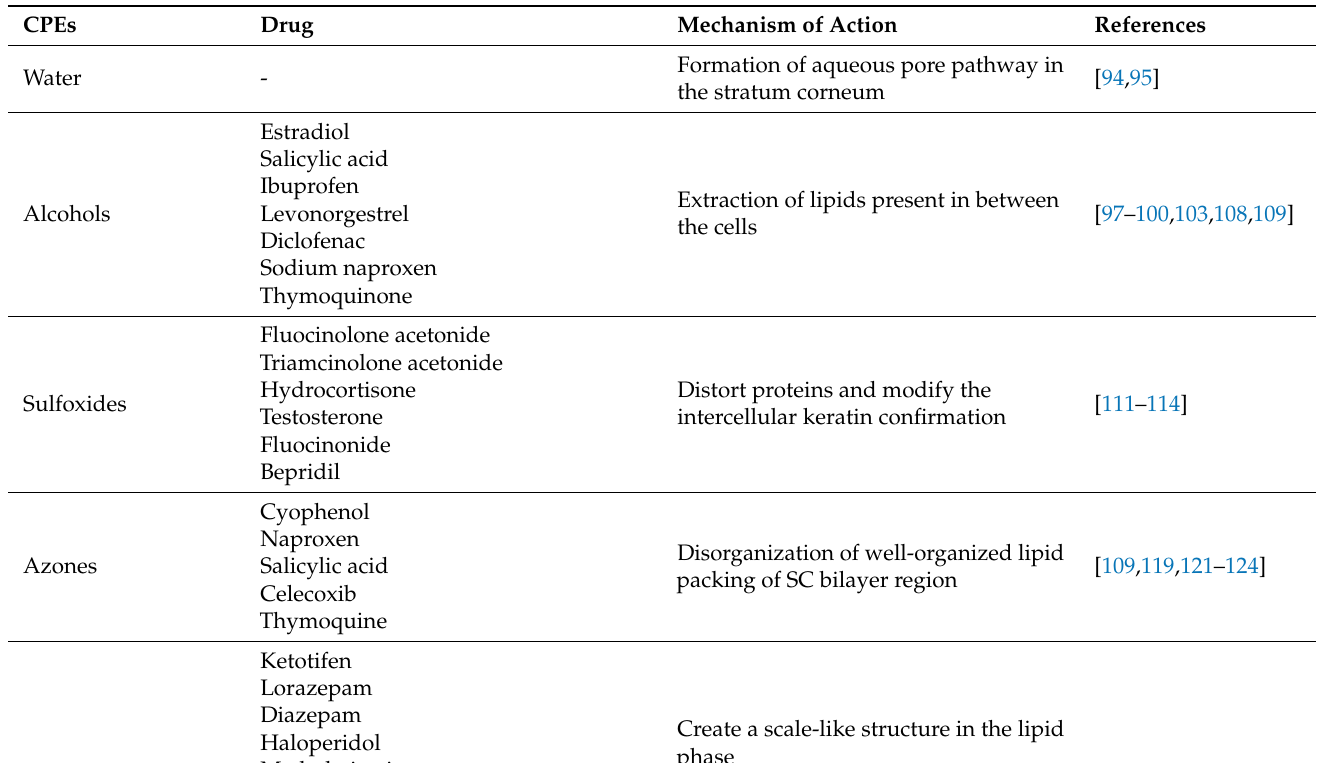
Table 1. CPEs employed in the transdermal delivery of various drugs along with the mechanism of